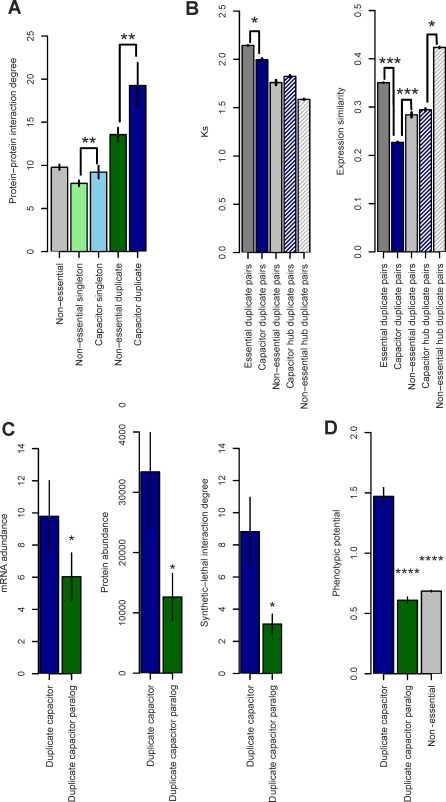
Characteristics of Capacitor Duplicates(A) The average number of affinity-capture mass spectrometry interactions of all nonessential genes (grey), all nonessential singletons (light green), capacitor singletons (light blue), all nonessential duplicates (dark green), and capacitor duplicates (dark blue).(B) Ks (left) and the expression similarity (right) between duplicate pairs that contain at least one essential gene (dark grey), at least one capacitor (solid dark blue), only nonessential noncapacitor genes (solid light grey), at least one gene product with over 19 PPIs annotated in the literature-curated BioGRID network and at least one capacitor (dark blue stripes), and at least one gene product with over 19 PPIs and no capacitors or essential genes (light grey stripes).(C) The mRNA abundance (left), protein abundance (middle), and SLI degree (right) of capacitors with only one paralog in the genome (blue) and their paralogs (green).(D) The phenotypic potential of capacitors with only one paralog in the genome (blue), their paralogs (green), and all nonessential genes (grey). Error bars represent the standard error of the mean. Unless otherwise marked, p-values are a comparison to duplicate capacitors, Wilcoxon-Mann-Whitney test: *, p < 0.05; **, p < 0.001; ***, p < 1 × 10−5; ****, p < 1 × 10−10.